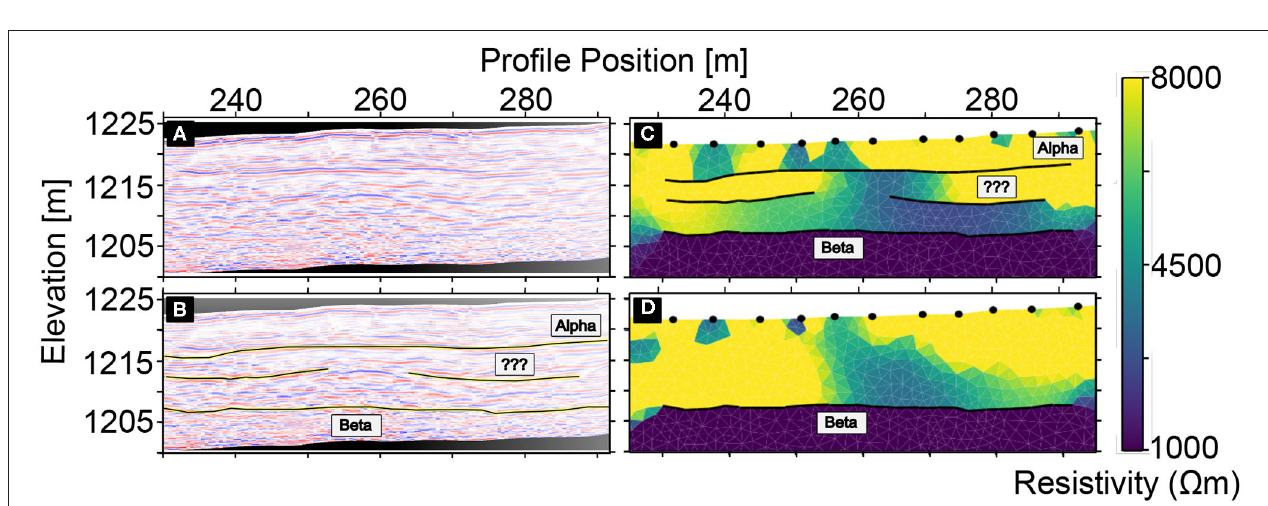
FIGURE 6 | (A) GPR profile G5.1. (B) Profile G5.1 with marked interfaces. (C) GPR-constrained ERT inversion result using all marked interfaces. (D) GPR-constrained ERT inversion result using only interface Beta .